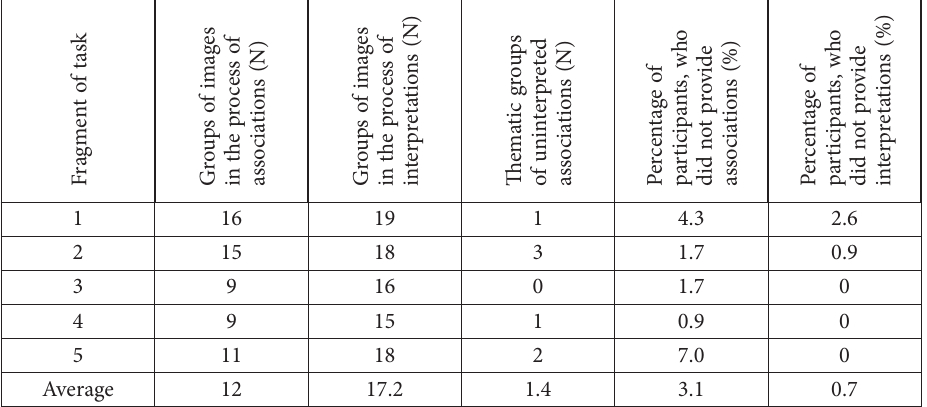
Table 11. Groups of images in the processes of association and interpretation (source: created by authors)